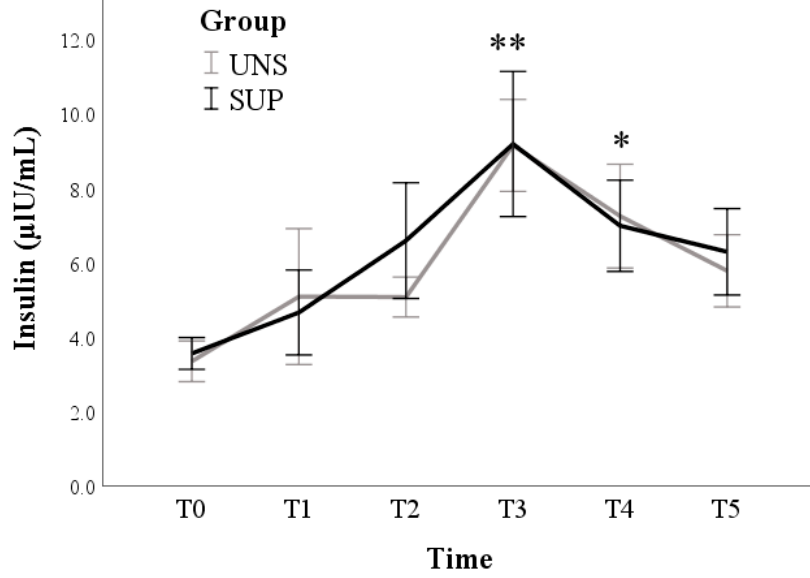
Figure 3. Means and standard errors of insulin plasma concentrations in control (UNS) and supple- mented (SUP) lactating sheep monitored before the administration of supplementation (T0), and then every 10 days until dry off (T1–T5). * p < 0.05, ** p < 0.01: each time vs. T0 in SUP and UNS. Glucagon levels were not affected by either time ( p = 0.331) or group ( p = 0.229) (Fig- ure 4).